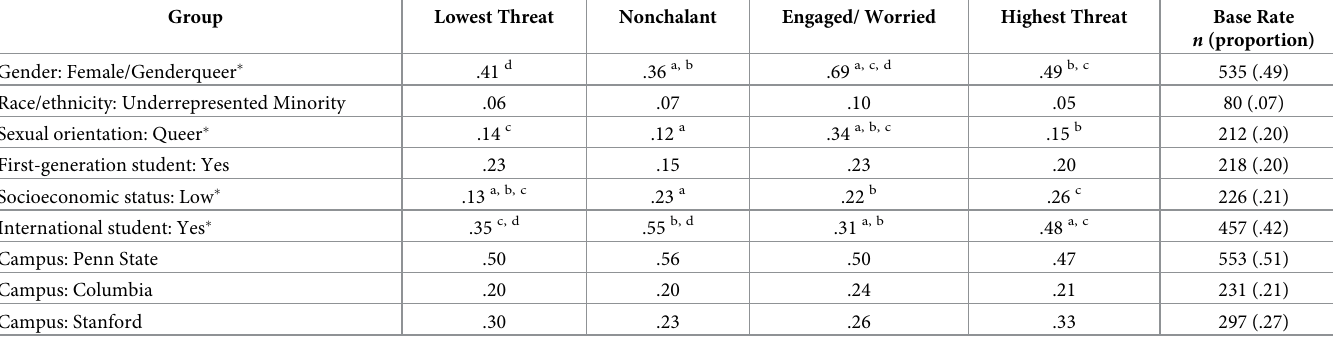
Table 5. Proportions of demographic groups by latent